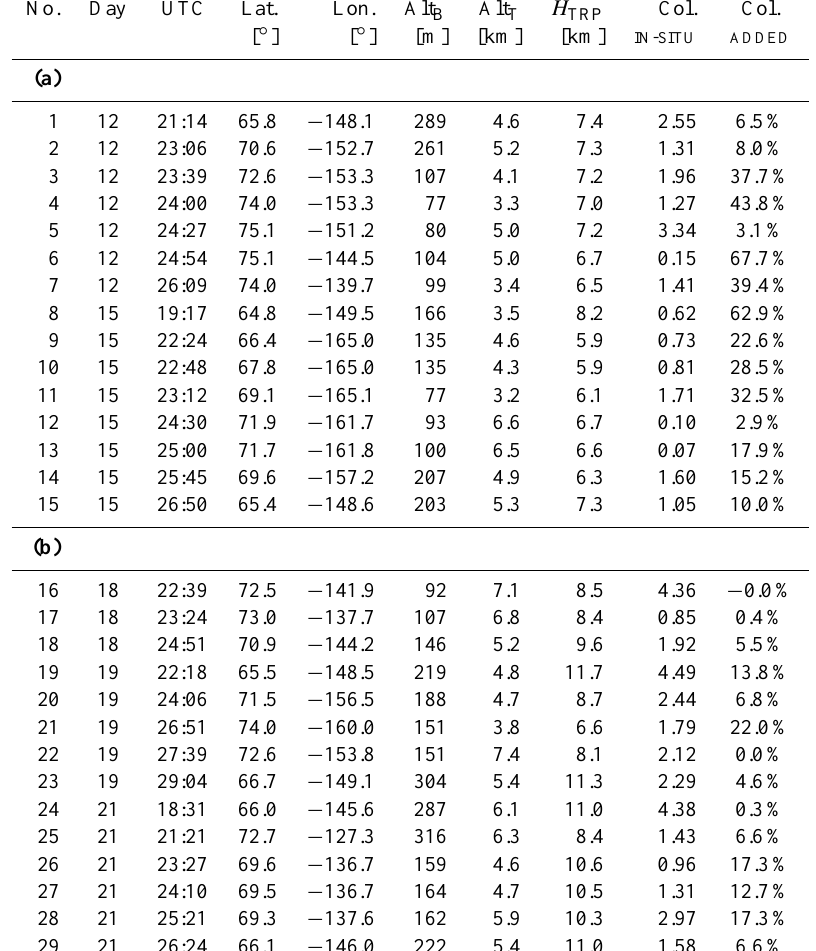
Table 2. Similar to Table 1 but for NOAA WP-3D profiles of BrO, measured on (a) 12 to 15 April 2008, (b) 18 to 21 April 2008.